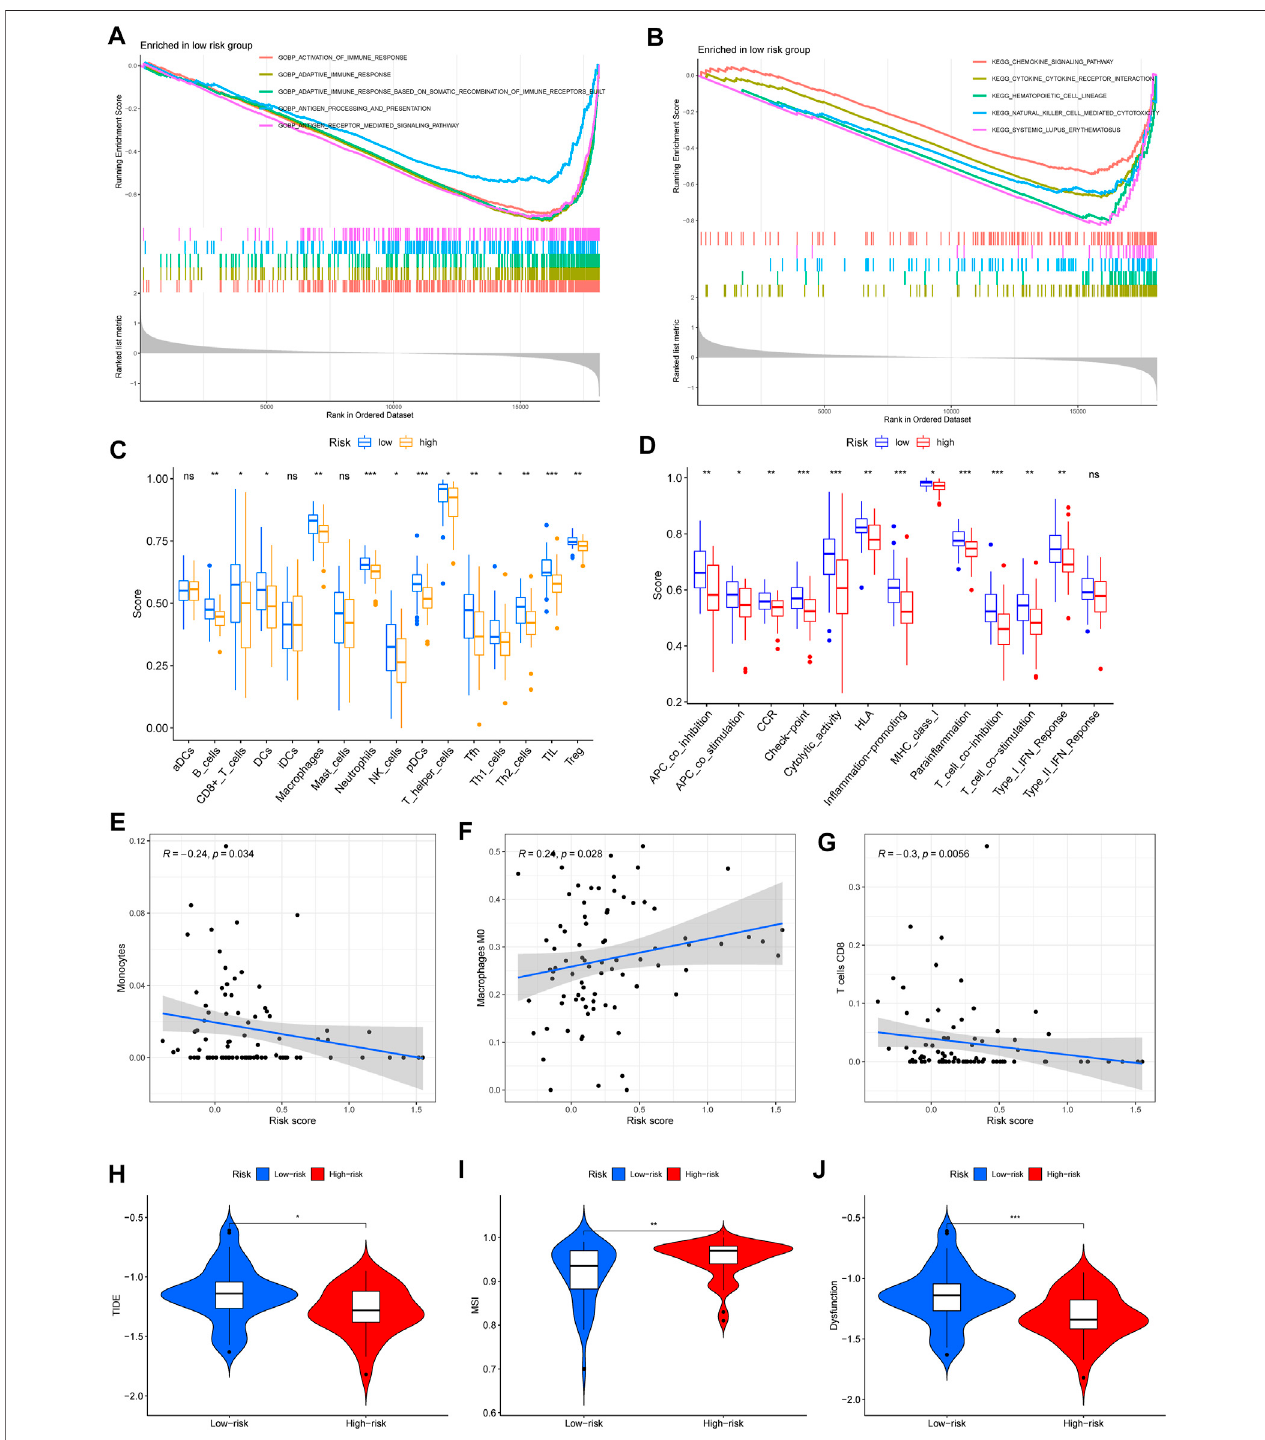
FIGURE 6 | Immune-related functions and immunotherapy response between the high- and low-risk groups. (A,B) Signi fi cantly enriched GO terms and KEGG pathways in low-risk groups. (C,D) Scores of immune cells and immune-related pathways in low- and high-risk groups. (E – G) The signi fi cant correlation between immune in fi ltration and risk scores, including monocytes, M0 macrophages, and CD8 T cells. (H – J) Analysis of TIDE, microsatellite instability (MSI), and dysfunction ( p p < 0.05; pp p < 0.01; and ppp p < 0.001).